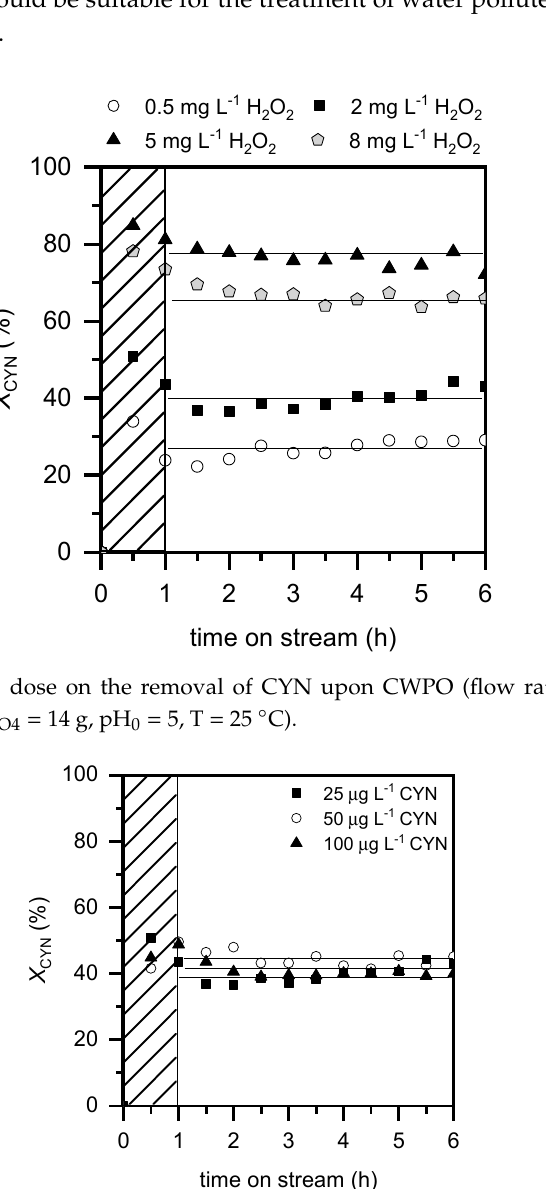
Figure 5. Effect of the initial concentration of CYN on its removal upon CWPO (flow rate = 0.2 mL min − 1 , [H 2 O 2 ] 0 = 2 mg L − 1 , W Fe3O4 = 14 g, pH 0 = 5, T = 25 °C).